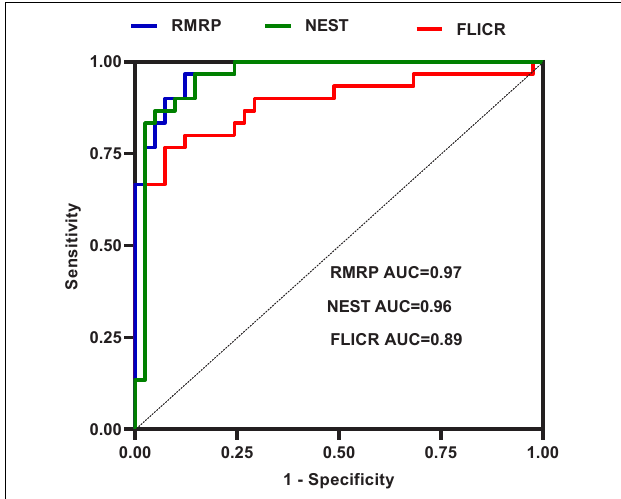
FIGURE 3 | Receiver operating characteristic curves of RMRP, IFNG-AS1, and FLICR lncRNAs transcript levels show their diagnostic power in the differentiation of total ASD cases from